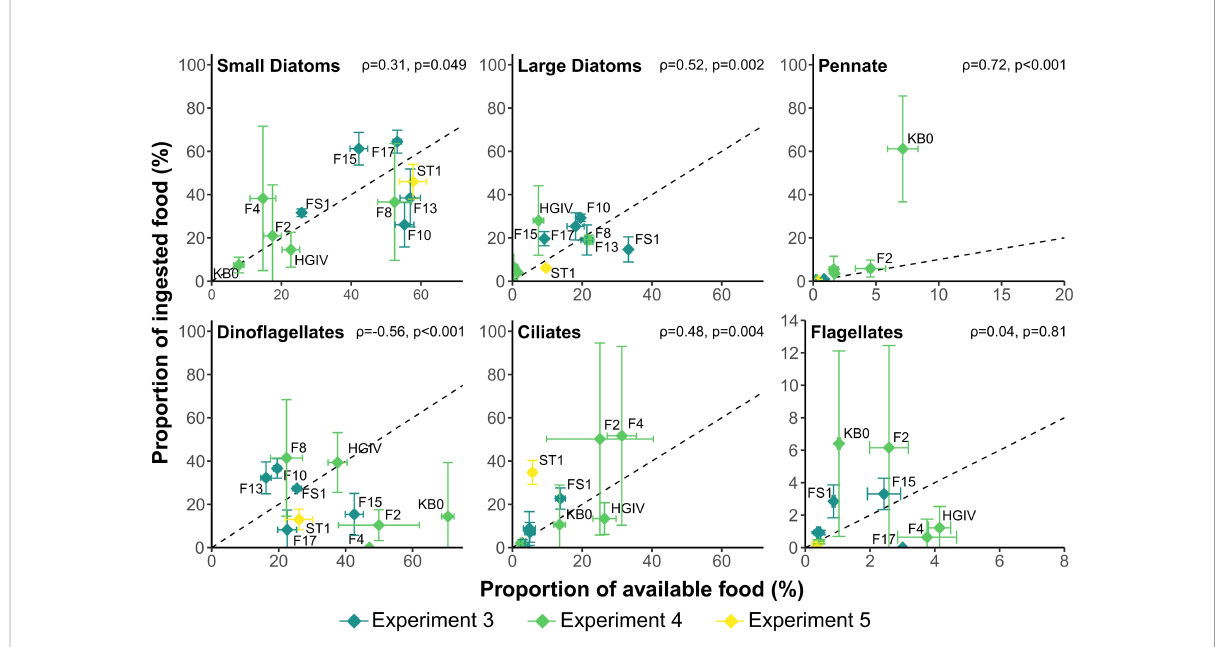
FIGURE 5 The contribution of food types to the diet of Calanus fi nmarchicus against the contribution of the food types to the available food environment. The dotted line represents the 1:1 line where ingestion is proportional to available food, i.e. non-selective feeding. Above this, a greater proportion is ingested than is available, so the food is selected for, and below, the food is selected against. Note the variable scales on the x- and